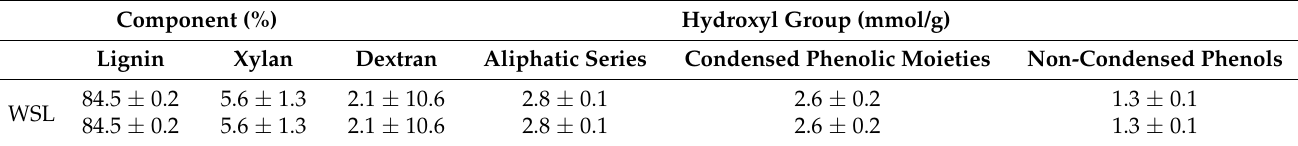
Table 2. Results of the chemical composition analysis and 31 P-NMR analysis of the WSL.